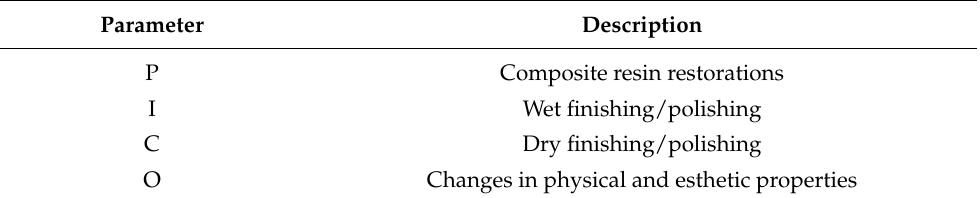
Table 1. Population, intervention, comparison, and outcome (PICO) question. Parameter Description P Composite resin restorations I Wet finishing/polishing C Dry finishing/polishing O Changes in physical and esthetic properties